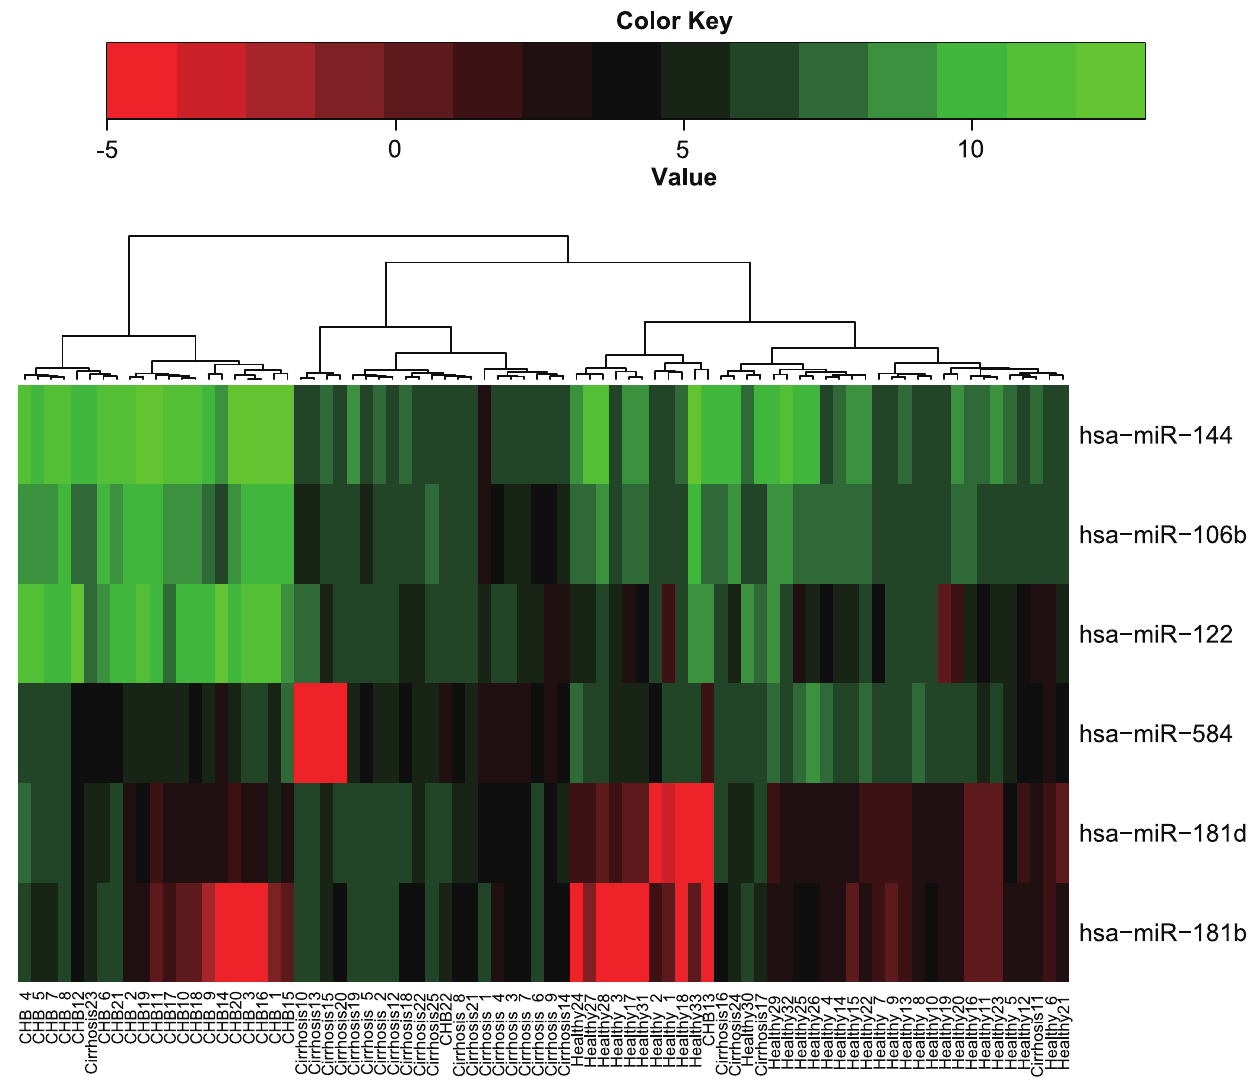
Figure 2. Hierarchical cluster analyses of the significantly regulated six miRNAs. Heat map colors represent the relative miRNA expression as indicated in the color key. bright green: over-expression; black: no change; bright red: under-expression.